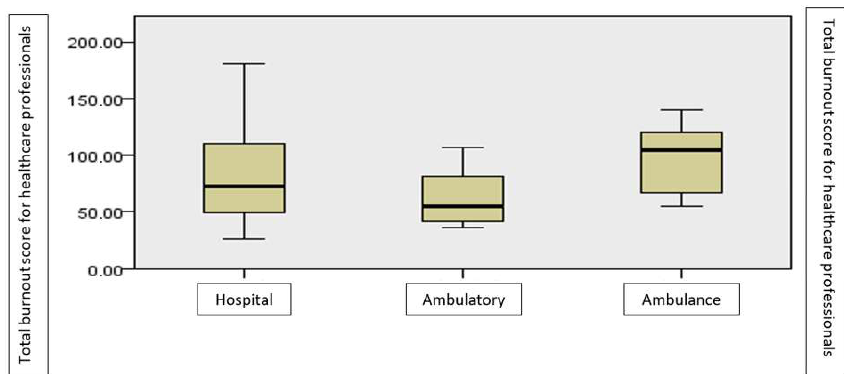
Figure 5. The average level of burnout according to the work type.